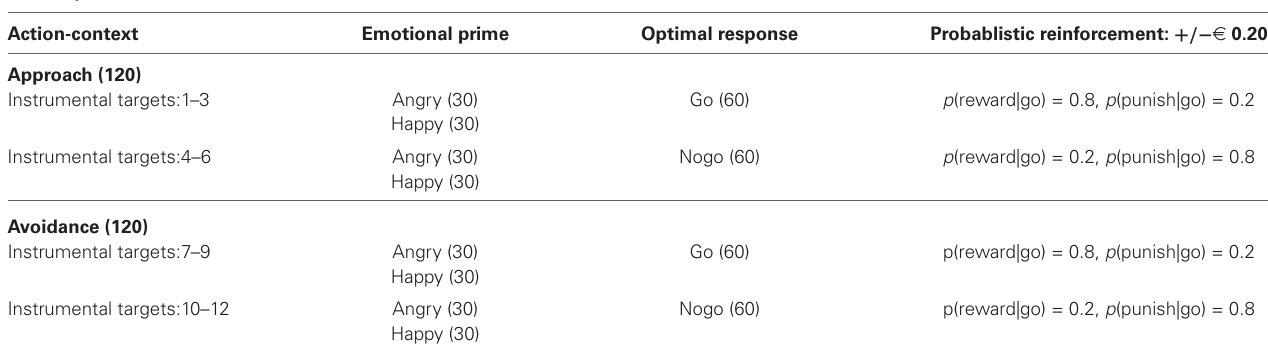
Table 1 | Task-design .